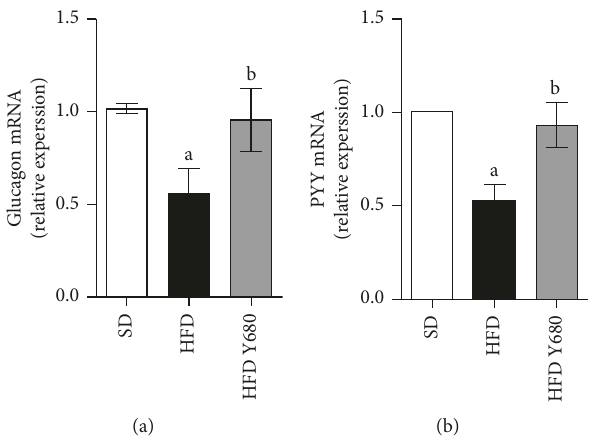
Figure 6: Effects of yacon flour on intestinal mRNA levels of proglucagon and PYY in HFD-fed rats. Proglucagon: Gcg (a) and polypeptide YY: Pyy (b) mRNA expression in intestinal samples of rats fed standard diet (SD) or high-fat diet (HFD) supplemented or not with yacon flour (680 mg FOS/kg body weight: HFD Y680) after 8 weeks of treatment. Data were normalized to Actin mRNA and expressed as fold change over the SD rats. Values are presented as mean ± standard deviation of triplicate PCR analysis ( n � 6/group). a p < 0 . 05 vs. SD, b p < 0 . 05 vs. HFD. SD: standard diet-fed rats; HFD: high-fat-diet-fed rats; HFD SD: high-fat-diet- fed rats reversed to a SD chow; HFD SY680: high-fat-diet-fed rats reversed to a SD chow and supplemented with yacon flour (680mg FOS/kg b.